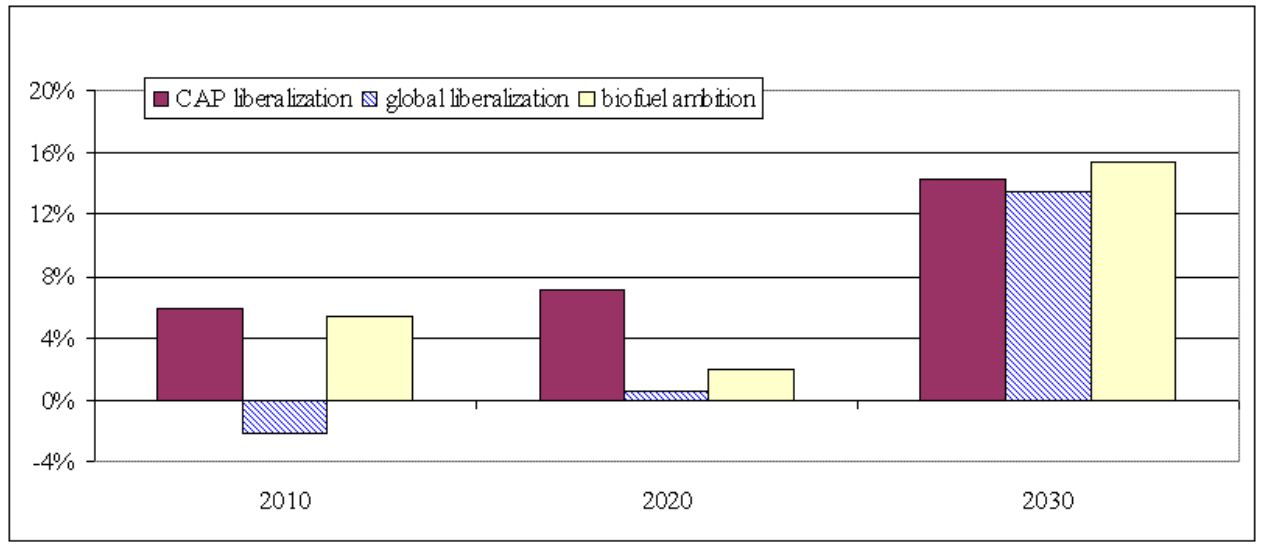
emissions in the Common Agricultural Policies 2